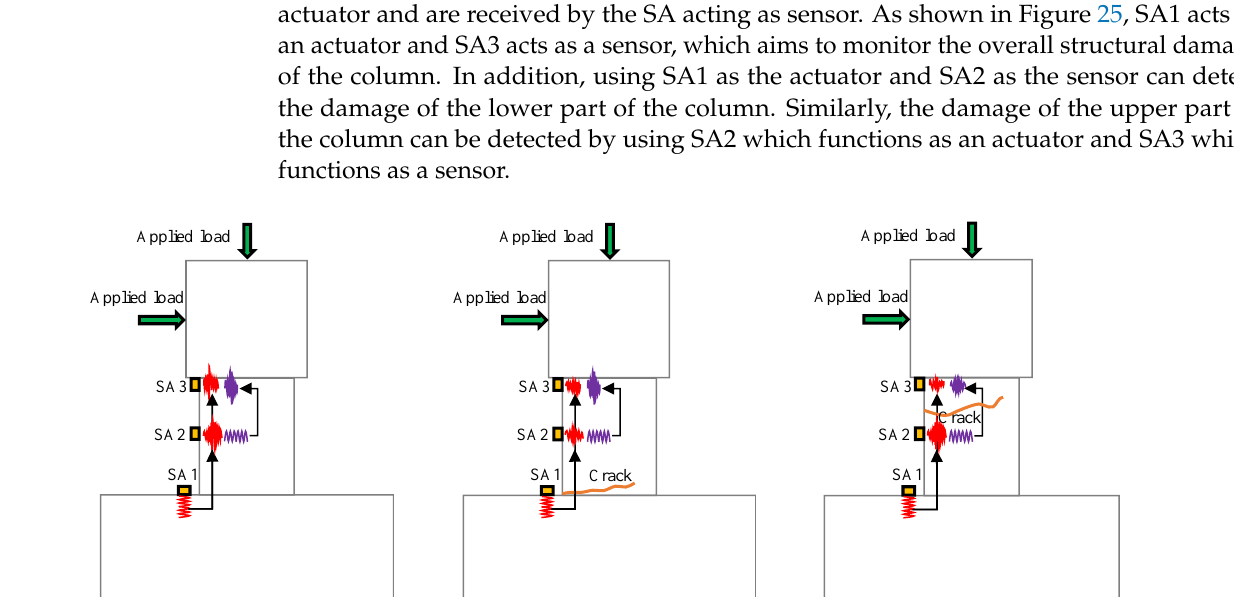
part, ( c ) Crack in the upper